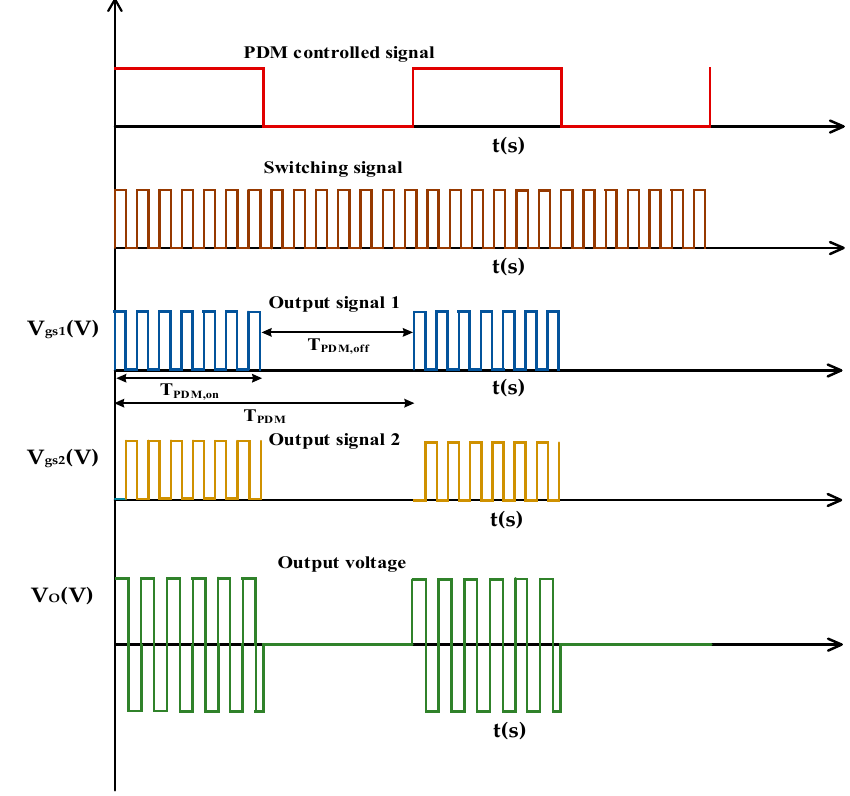
Figure 7. PDM pulse generation and its typical voltage waveform.